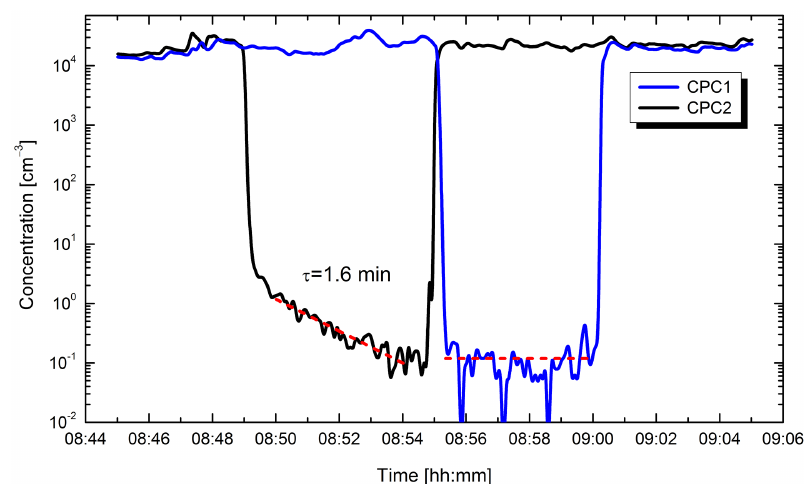
Figure 3. Temporal response of two identical CPCs to the concentration change caused by adjusting the same HEPA filter to them in a stepwise manner. The dashed lines show the fitted linear curves. Relaxation time τ of the slower CPC is also indicated.